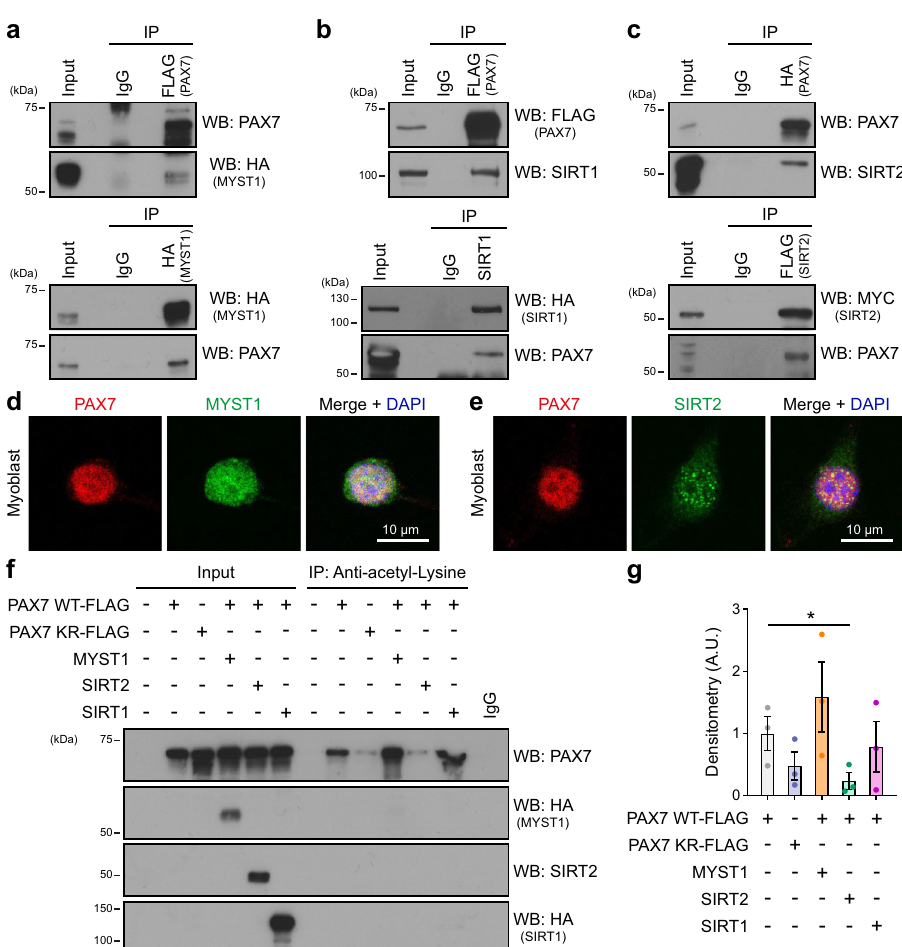
Fig. 2 PAX7 protein interacts with MYST1, SIRT1, and SIRT2. a PAX7 interacts with MYST1. Cells were transfected with plasmids expressing HA-MYST1 and FLAG-PAX7, as indicated. The interaction between PAX7 and MYST1 was determined by immunoprecipitation using anti-FLAG antibodies (top) or anti-HA antibodies (bottom). Immunoblotting was performed with the indicated antibodies. b PAX7 interacts with SIRT1. Cells were transfected with plasmids expressing HA-SIRT1 and FLAG-PAX7, as indicated. The interaction between PAX7 and SIRT1 was determined by immunoprecipitation using anti- FLAG antibodies (top) or anti-SIRT1 antibodies (bottom). Immunoblotting was performed with the indicated antibodies. c PAX7 interacts with SIRT2. Cells were transfected with plasmids expressing MYC-SIRT2-FLAG and HA-PAX7, as indicated. The interaction between PAX7 and SIRT2 was determined by immunoprecipitation using anti-HA antibodies (top) or anti-FLAG antibodies (bottom). Immunoblotting was performed with the indicated antibodies. d , e Representative confocal images displaying the co-localization between PAX7 and MYST1 ( d ) or SIRT2 ( e ). Primary myoblasts were immunostained with PAX7 (red) and MYST1 or SIRT2 (green), and nuclei were counterstained with DAPI (blue). Scale bar represents 10 μ m. Images are representative of ≥ 80% of the cells examined ( n = 3 experiments from biologically independent samples). f PAX7 acetylation levels are regulated by MYST1 and SIRT2. Cells were transfected with plasmids encoding PAX7 (WT or K105/193R), MYST1, SIRT2, and SIRT1, and lysates were subjected to immunoprecipitation using anti-acetyl-lysine antibodies. Immunoblotting was performed with the indicated antibodies. g Quanti fi cation of the immunoblotting signals from ( f ). The densitometric analysis of the level of acetylated PAX7, relative to total PAX7 signal, is shown. Data are presented as mean values± SEM ( n =